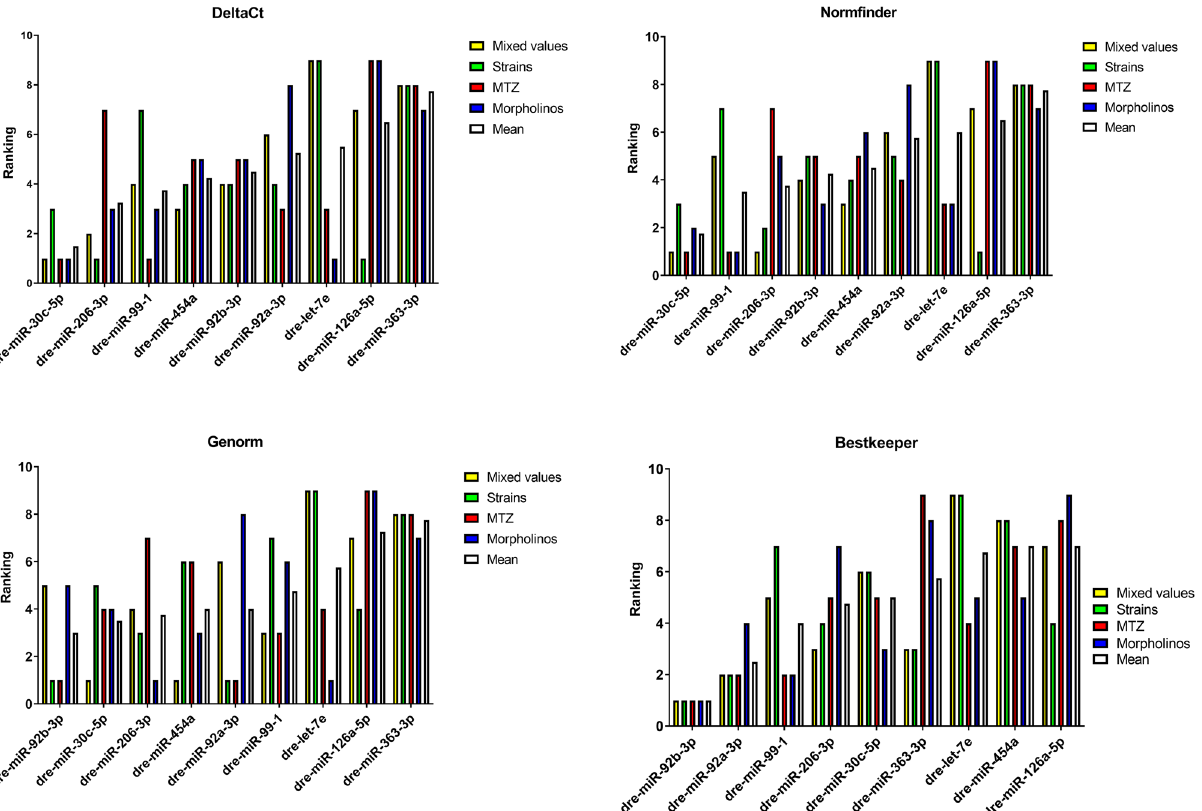
Figure 4. Ranking of potential endogenous control miRs by 4 different normalization determination softwares. Data was ranked by DeltaCt, Normfinder, Genorm and Bestkeeper with respect to mixed values, strains only, MTZ only and morpholinos only as well as the mean